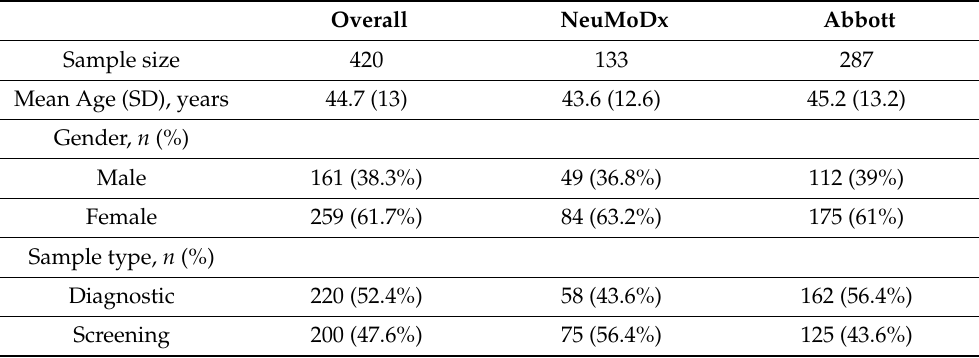
Table 1. Demographic characteristics of the study population. SD: standard